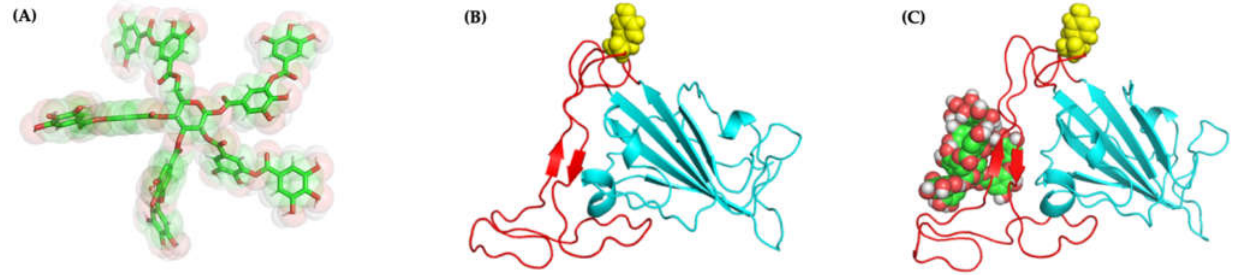
Figure 7. Molecular structures and docking of TA/RBD complex: one possible structure of ( A ) TA, ( B ) RBD (N501Y) (molecular dynamics (MD) 100 ns), and ( C ) TA/RBD (N501Y) complex (pose 1; highest docking binding affinity of − 6.8 kcal/mol). The N501Y mutation is yellow.